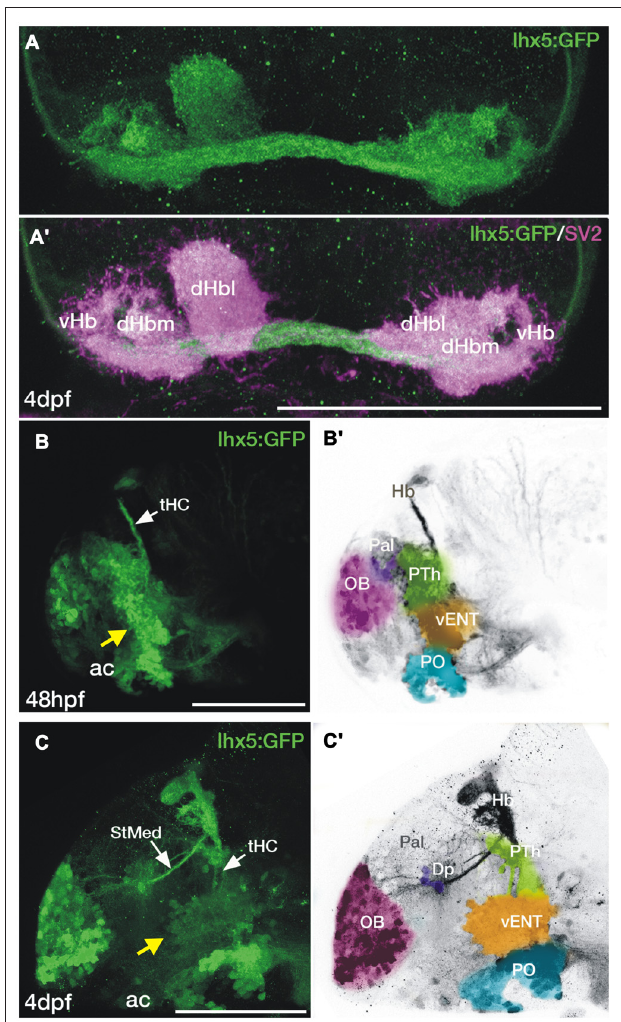
FIGURE 5 | Transgene expression in the forebrain of Tg(lhx5:GFP) b1205 embryos and larvae. (A,A (cid:48) ) Dorsal views of the habenula of a 4dpf Tg(lhx5:GFP) b1205 fish labeled with anti-GFP only (A) or anti-GFP (green) and anti-SV2 (magenta) antibodies (A (cid:48) ) . GFP+ axon terminals (green) innervate all habenula neuropil domains visualized with SV2 (magenta). (B–C (cid:48) ) Lateral views of the forebrain of a Tg(lhx5:GFP) b1205 fish at 48 hpf (B,B (cid:48) ) and 4dpf (C,C (cid:48) ) . (B) GFP+ cells and processes in 48 hpf Tg(lhx5:GFP) b1205 . Note that the tract of the habenular commissure is labeled at this stage (tHC, white arrow). Yellow arrow points to putative prethalamic eminence/vENT. (B (cid:48) ) Image shown in (B) has been converted to gray scale and false colored areas show the different presumptive domains. GFP+ cells and processes form a continuous band at the telencephalic-diencephalic boundary (B) , extending from presumptive prethalamus (PTh, labeled in green), through the putative prethalamic eminence/vENT (vENT, labeled in yellow) and preoptic regions (PO, labeled in blue). A number of GFP+ neurons are also present in the olfactory bulb (OB, labeled in pink). (C) GFP+ cells and processes in 4dpf Tg(lhx5:GFP) b1205 fish. Note that at this stage the main afferent tracts to the habenula, the stria medullaris (StMed) and the tract of the habenular commissure (tHC) are visible. Yellow arrow points to putative prethalamic eminence/ vENT. (C (cid:48) ) Image shown in (C) has been converted to gray scale and false colored areas show the different presumptive domains. There are a number of GFP+ cells rostrally in the OB (pink area), a few GFP+ cells and fibers in Dp (purple). Prethalamus, vENT and preoptic regions are again labeled in green, yellow and blue respectively. Scale bars: All 100 µ